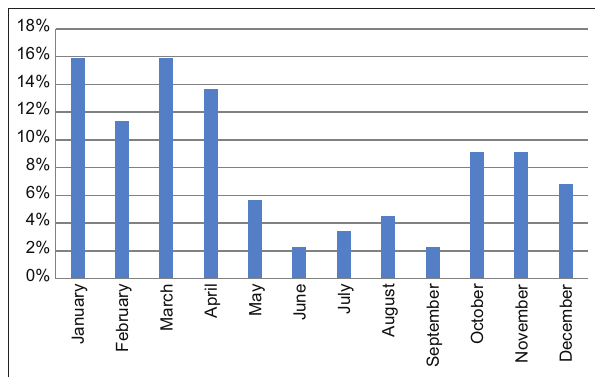
Figure-1: Mortality rate of adult dairy cows per month over a 3‑year period (2016−2018) in a single intensively managed dairy farm in Jordan (n = Table-1: Body systems and diseases/accidents causing mortality (n = 88) and culling (n = 102) of adult dairy